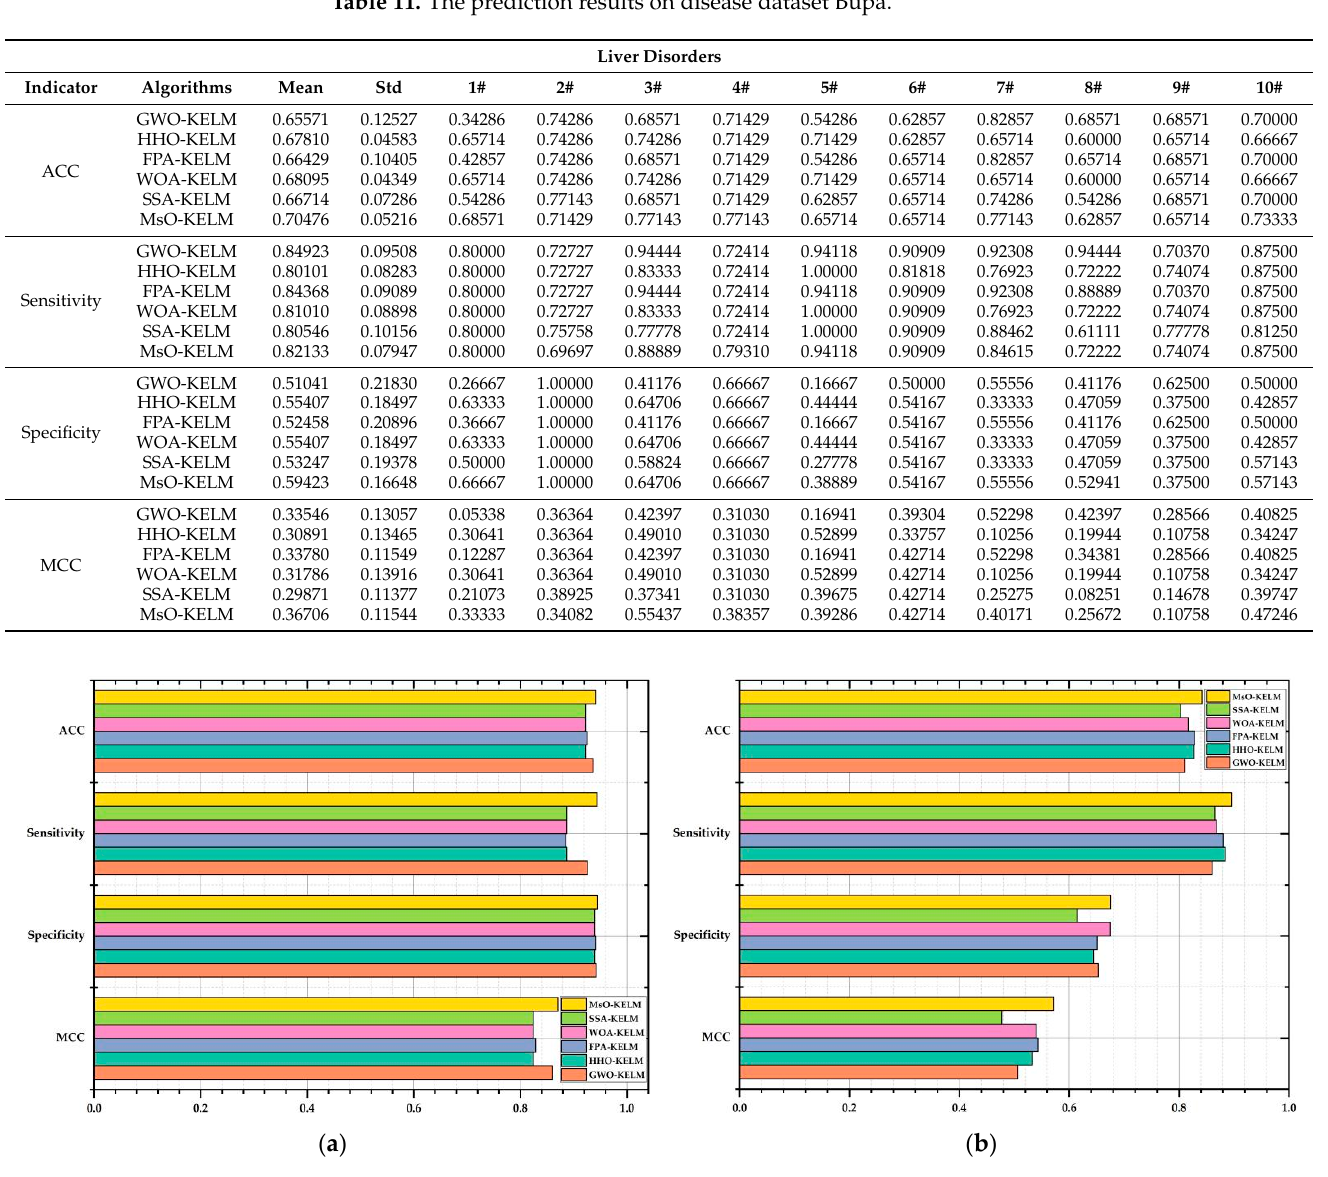
Figure 6. The figure of evaluation metric results on Autistic and Heart Disease. (a) the evaluation criterion result on Autistic; (b) the evaluation criterion result on Heart Disease.